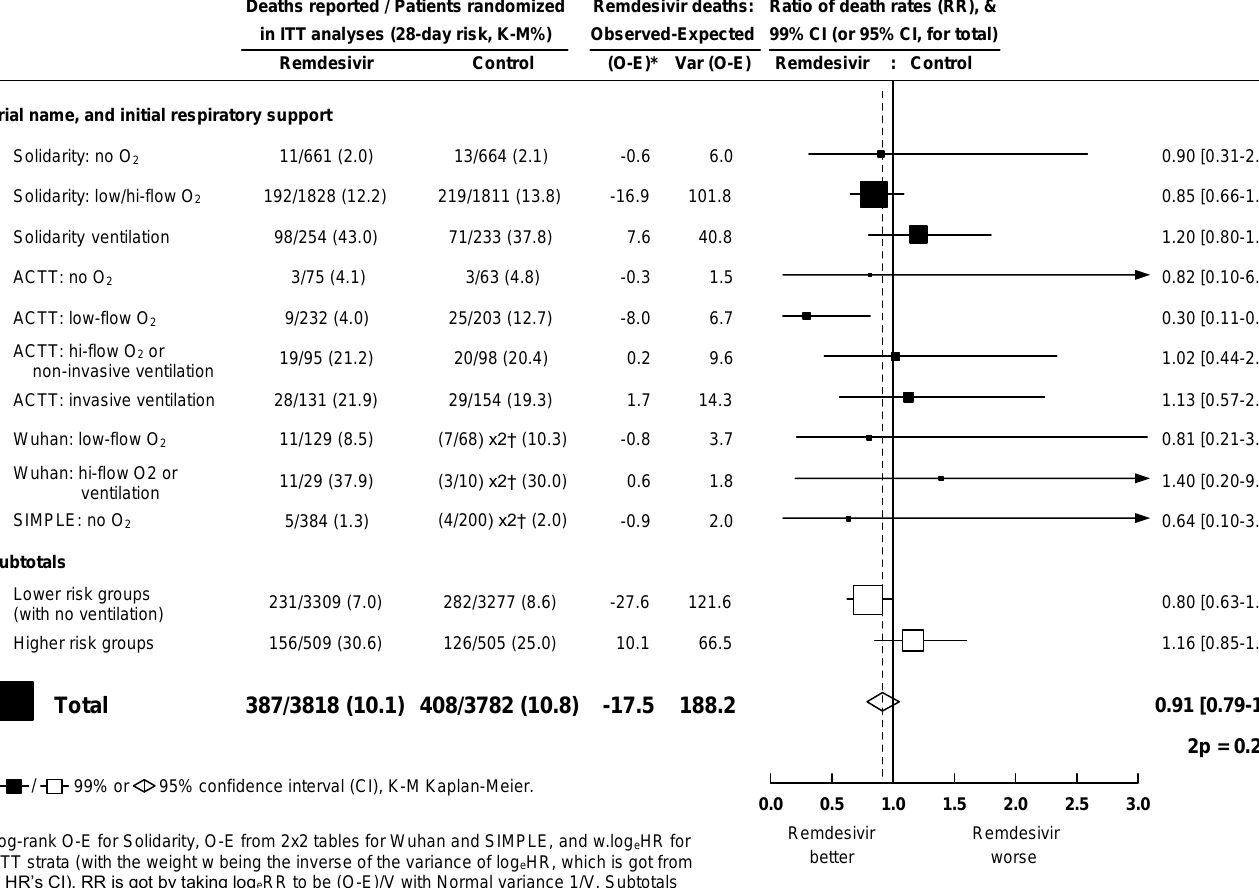
Figure 4. Remdesivir vs control – Meta-analysis of mortality in trials of random allocation of hospitalised COVID-19 patients to Remdesivir or the same treatment without